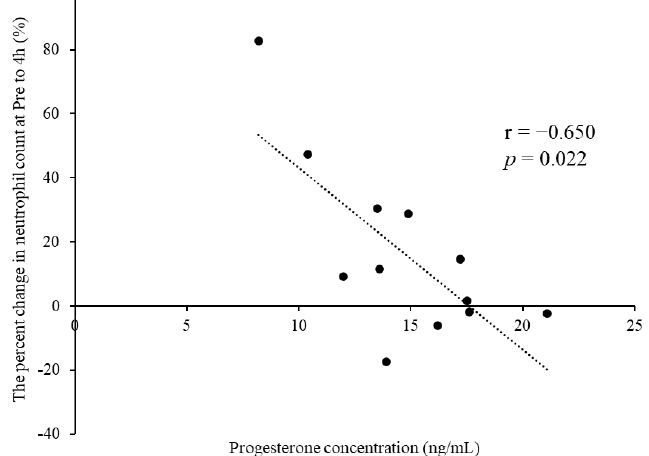
Figure 2. Significant negative correlation observed between the progesterone concentration and percent change in neutrophil counts from pre- to 4 h postexercise in the mid-luteal phase group.